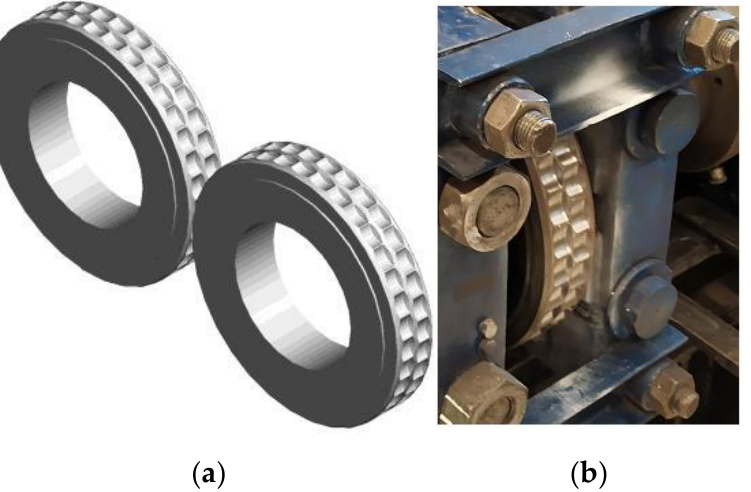
Figure 2. The laboratory roller press LPW 450: ( a ) the view [47], ( b ) the scheme: ( 1 ) gear motor with a cycloidal transmission; ( 2 ) flexible clutch; ( 3 ) gearbox; ( 4 ) enclosure of Oldham couplings and friction clutch; ( 5 ) molding rollers cage; ( 6 ) gravity feeder; ( 7 ) hydraulic system of sliding roller support.